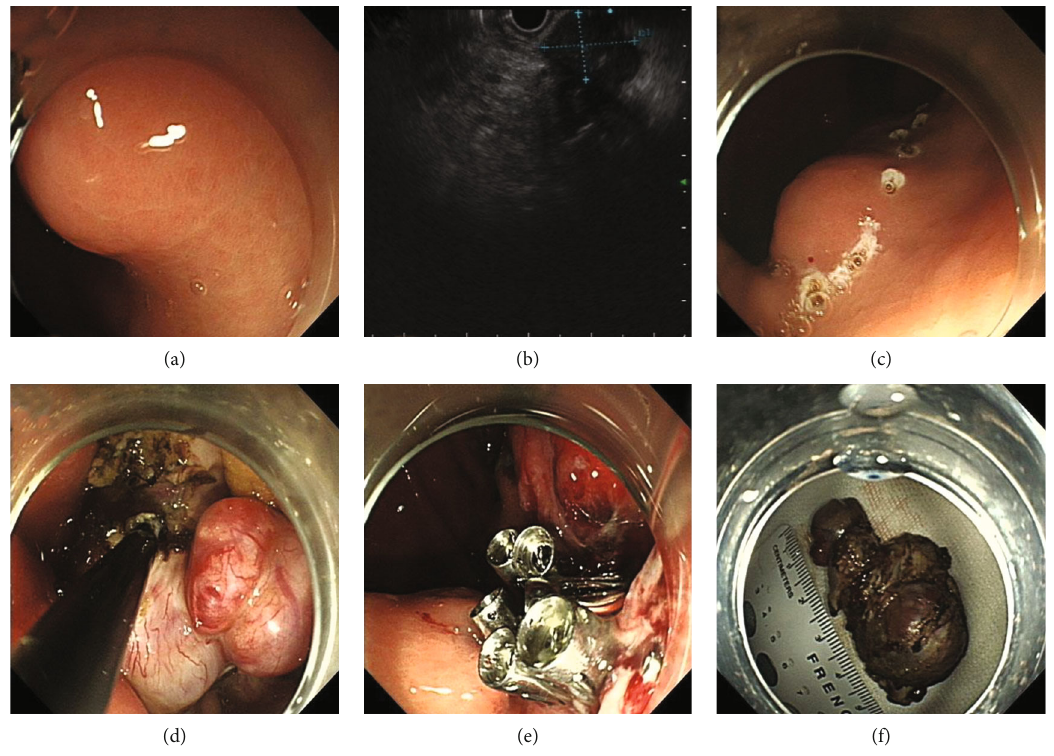
Figure 2: Endoscopic full-thickness resection treatment for a gastric GIST: (a) gastric GIST identi fi ed by endoscopy; (b) the same gastric GIST observed by endoscopic ultrasound; (c) marking outside the tumor; (d) resection of the tumor; (e) close the wound; (f) the resected tumor. GIST: gastrointestinal stromal